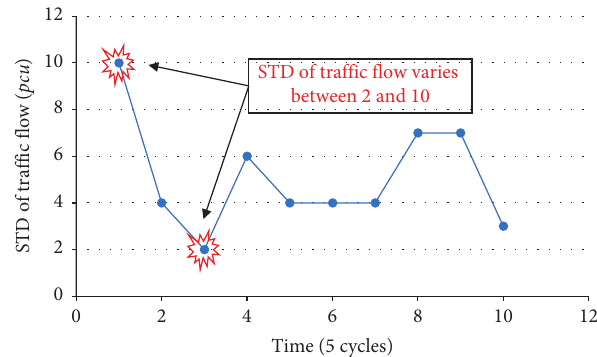
Figure 1: The standard deviation of traffic